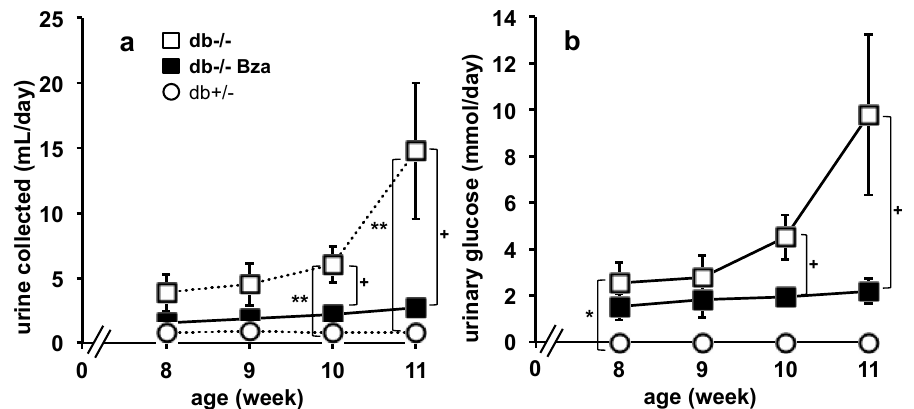
Figure 2. Benzylamine supplementation lowers urine production and glucose urinary output in obese/diabetic mice. ( a ) Daily urine emission of db-/- (open squares), Bza-drinking db-/- (closed squares) and db+/- mice (open circles) at the age of 8–11 weeks, once isolated in metabolic cages for 24 h. ( b ) Daily urinary glucose output. Mean ± SEM of the following numbers of mice, with the ratio of males/females indicated in parentheses: 11 (5/6) for db-/-; 9 (5/4) for Bza-db-/-; 10 (5/5) for db+/-. Significant influence of the genotype at: * p < 0.05, ** p < 0.01 for db-/- vs. db+/-; significant difference at: + p < 0.05 for db-/- vs. Bza-db-/- mice.